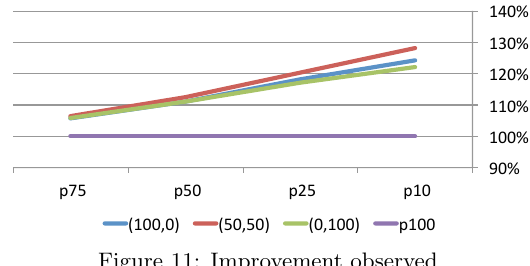
Figure 11: Improvement